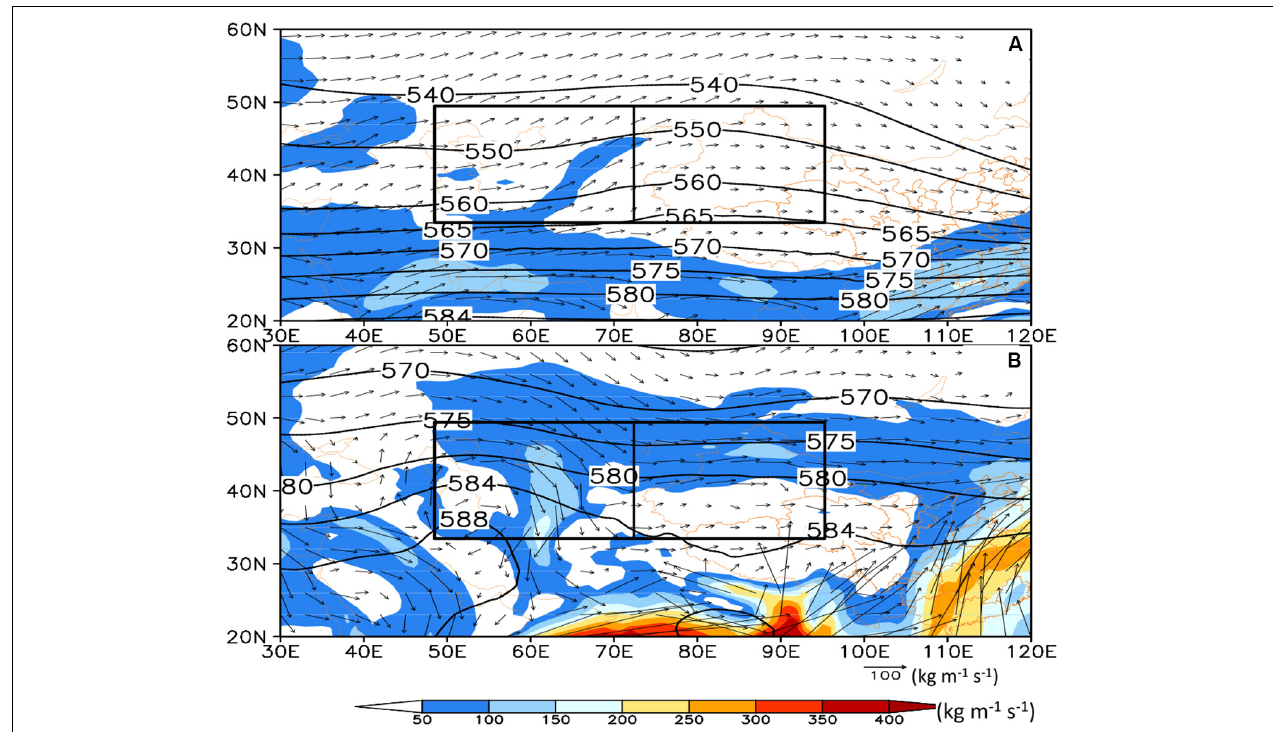
FIGURE 8 | Vertically integrated water vapor transport (vectors and shading; units: kg m − 1 s − 1 ) from the ground to 200 hPa and the geopotential heights at 500 hPa (contours; units: gpm) in (A) winter and (B) summer from 1979 to 2017. The black boxes denote regions I and II.